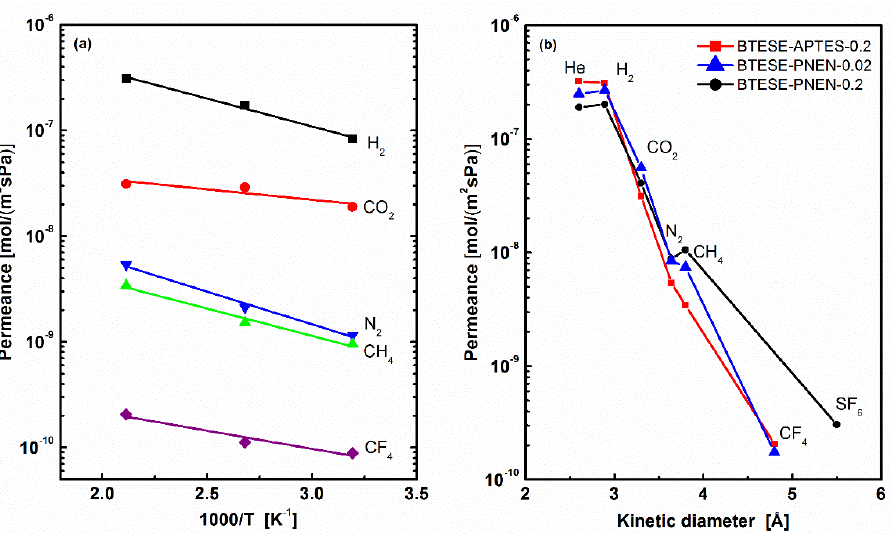
Figure 7. ( a ) Temperature dependence of gas permeance of BTESE-APTES-0.2 membrane and ( b ) kinetic diameter dependence of gas permeance of BTESE-APTES-0.2, BTESE-PNEN-0.2 and BTESE-PNEN-0.02 membranes at 200 °C. Table 4. Gas permeance and related permselectivity of BTESE-APTES-0.2 membranes. Test